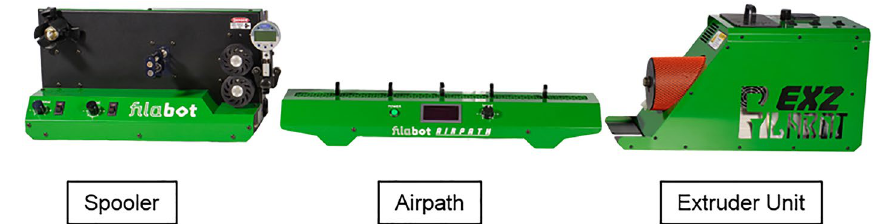
Fig. 3 EX 2 extruder from Filabot. A note on Extruder EX 2: the control of the speeds in the entire system is done by rotary potentiometers, which makes it impossible to give exact values. All values in Table 3 are experimentally determined values